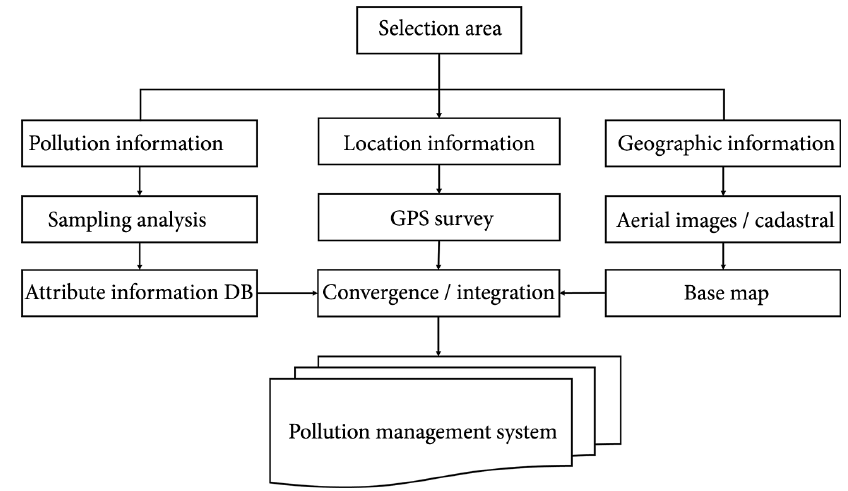
Figure 1. Process of developing a pollution management